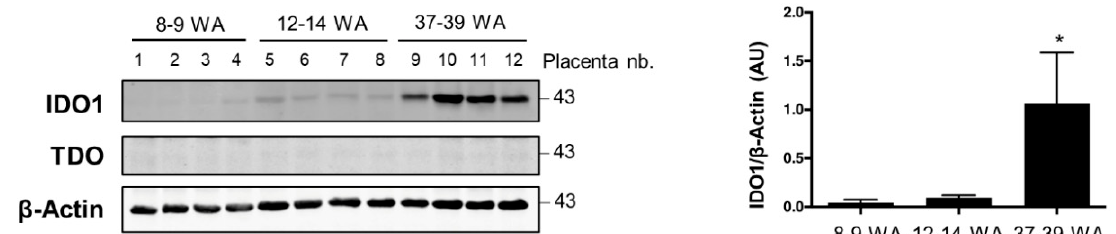
Figure 3. Indoleamine 2,3-dioxygenase 1 enzyme (IDO1) protein expression in placenta from different periods of pregnancy. Total protein extracts from placenta at different stages of pregnancy, as indicated, were analyzed by immunoblotting using anti-IDO1 and anti-TDO2 antibodies. β -Actin was used as a loading control. Quantification of IDO1 immunoblots relative to β -Actin was determined using the Odyssey System Imager and is shown in the bar scale graph. *compared to 8–9 WA, p < 0.05, n = 4 (lower panel).